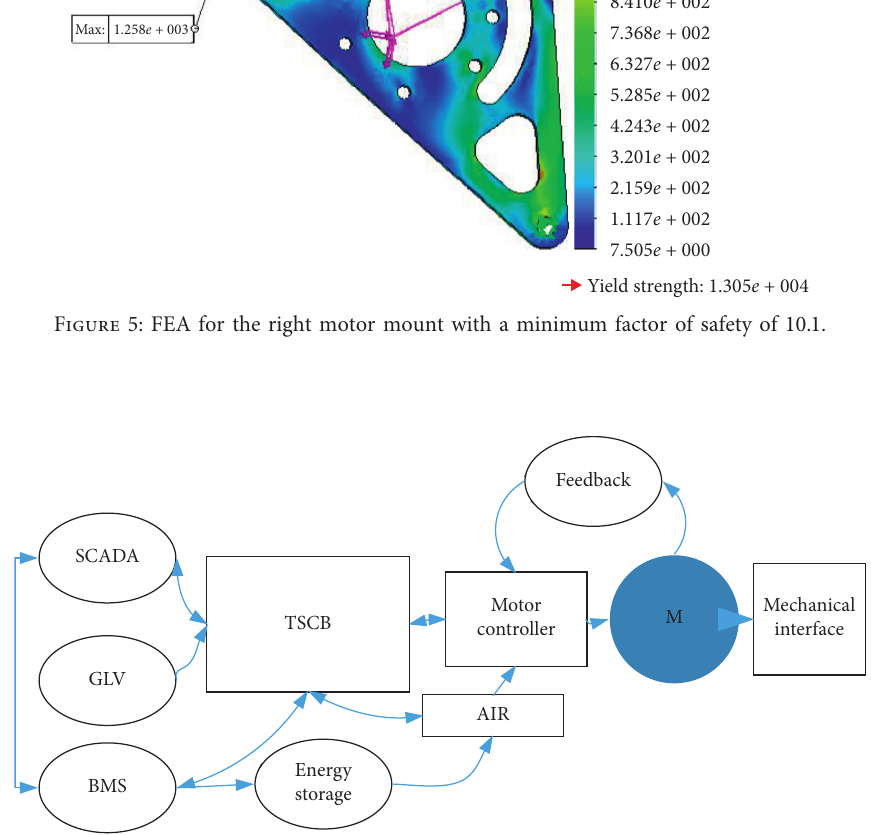
Figure 6: Overall operation and communication of the drivetrain